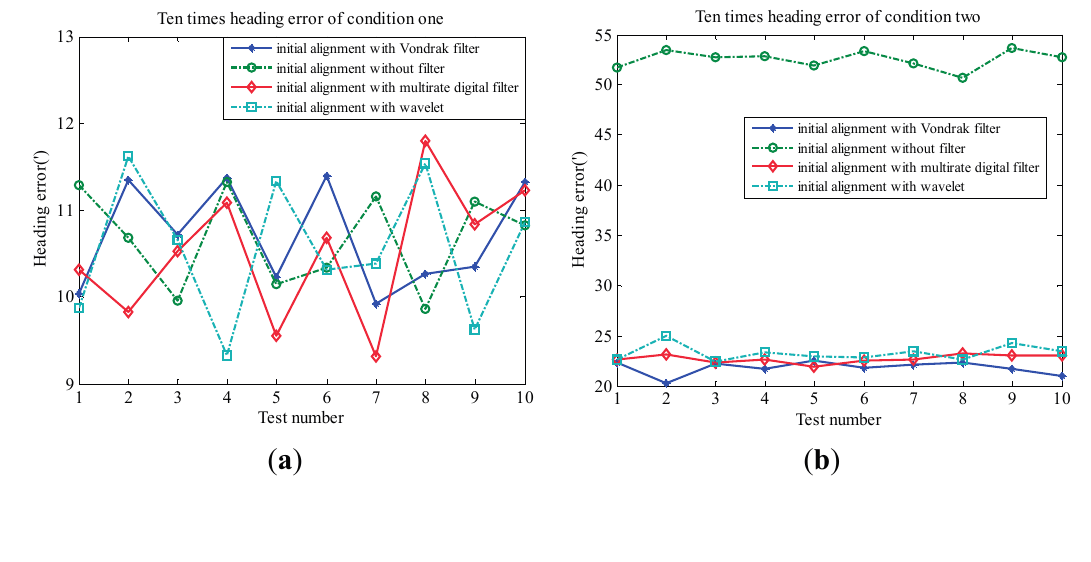
Figure 9. Ten times heading error of different schemes: ( a ) condition one; ( b ) condition two; ( c ) condition three; ( d ) condition